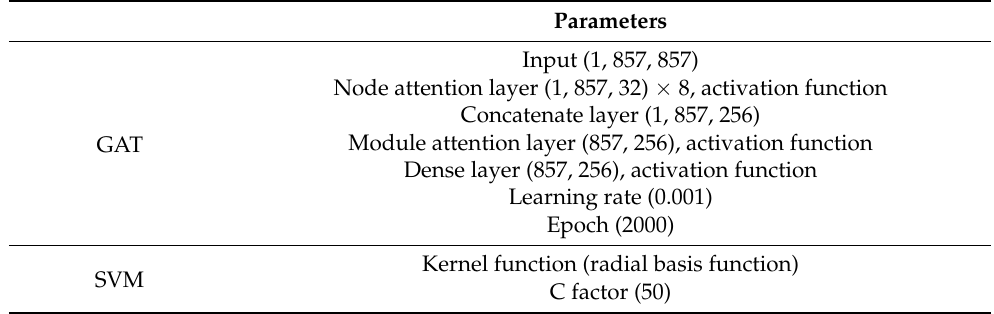
Table 7. The framework and parameters of